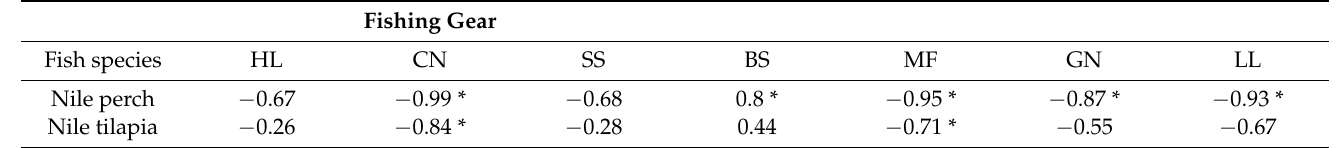
Table 7. Correlation between fish catches and fishing gear used on Lake Kyoga from 2010 to 2018. Fishing